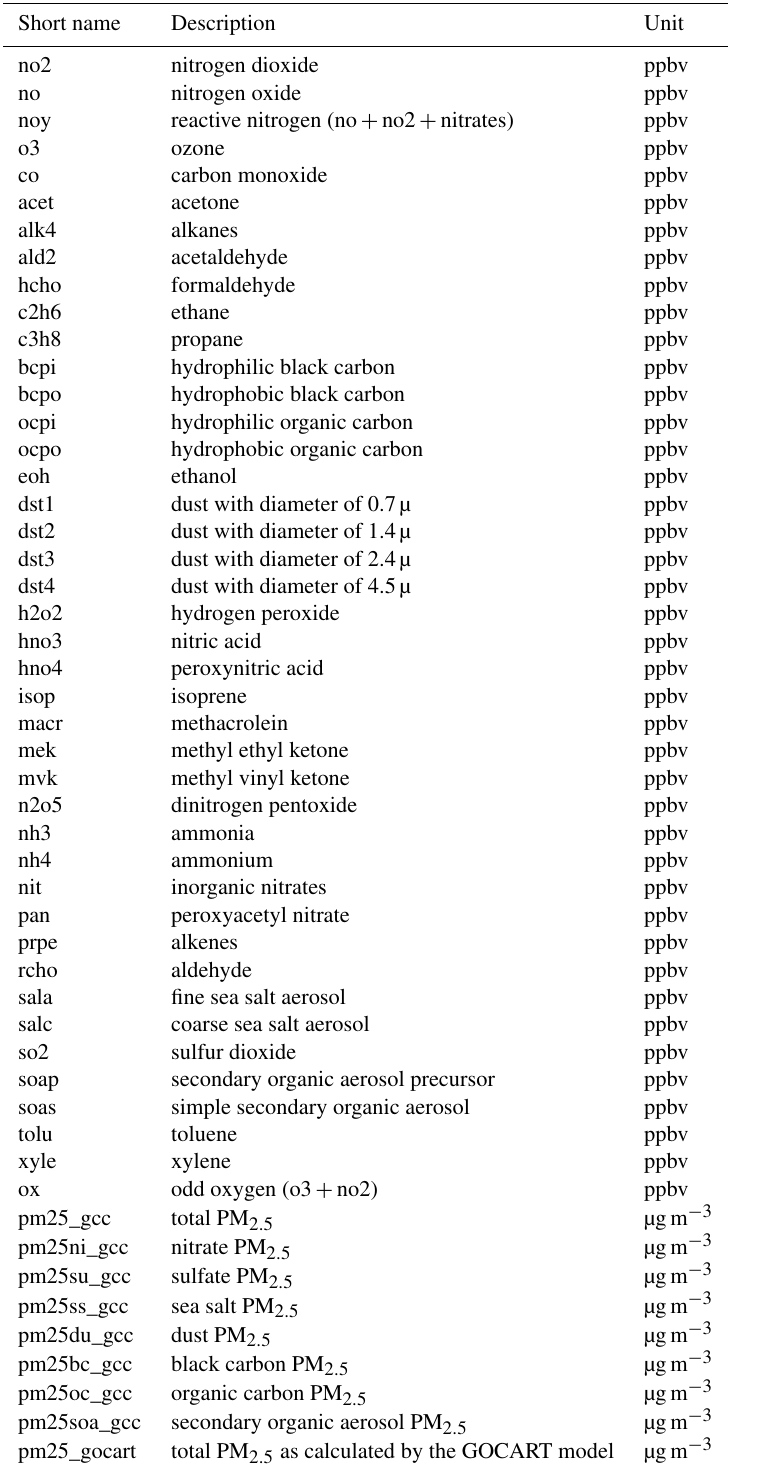
Table A1. List of input features fed into the XGBoost machine learning